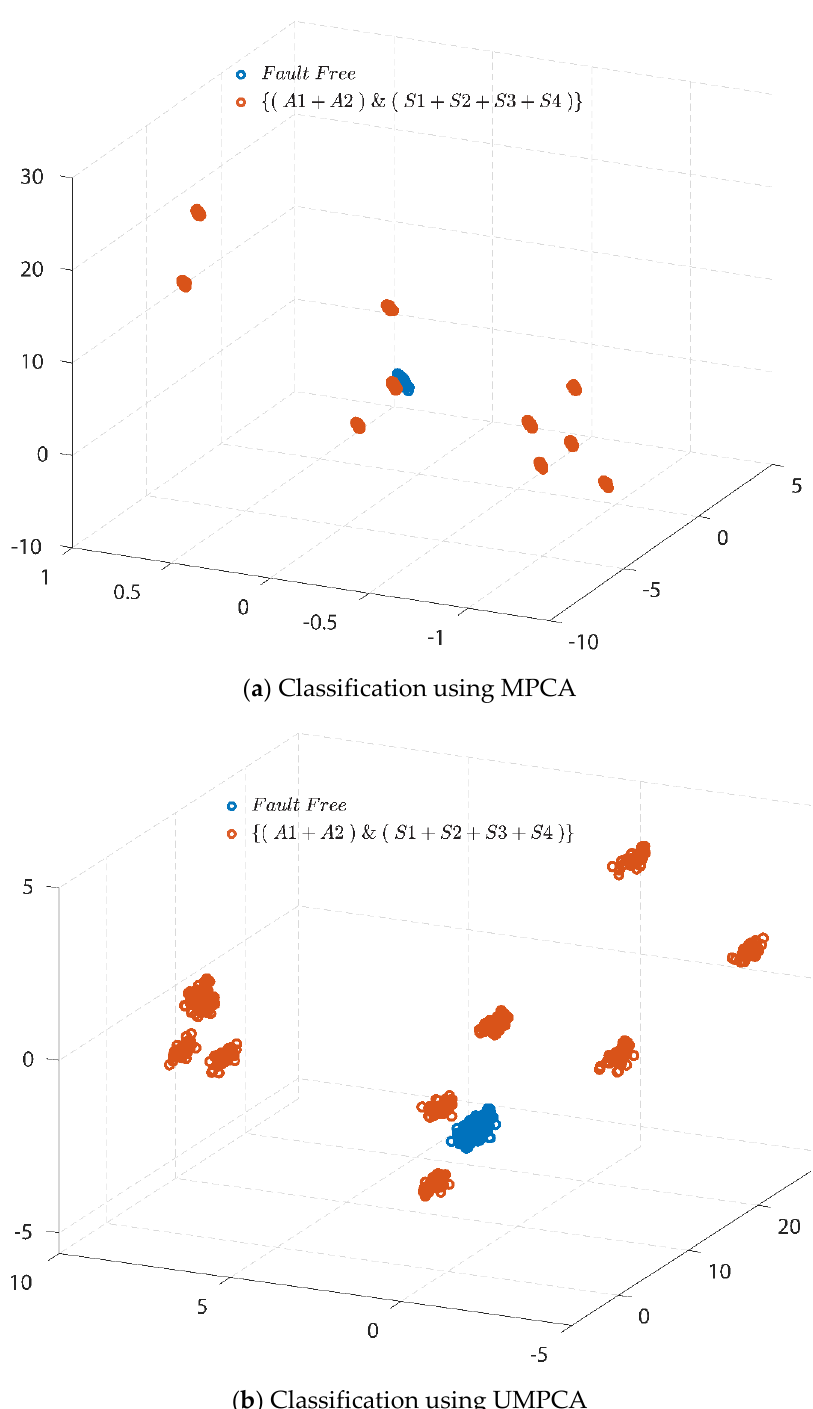
Figure 18. Three-dimensional space visualization performance for fault classification for wind turbines subjected to two actuator and four sensor faults under AWGN noises, using ( a ) MPCA and ( b ) UMPCA, respectively.